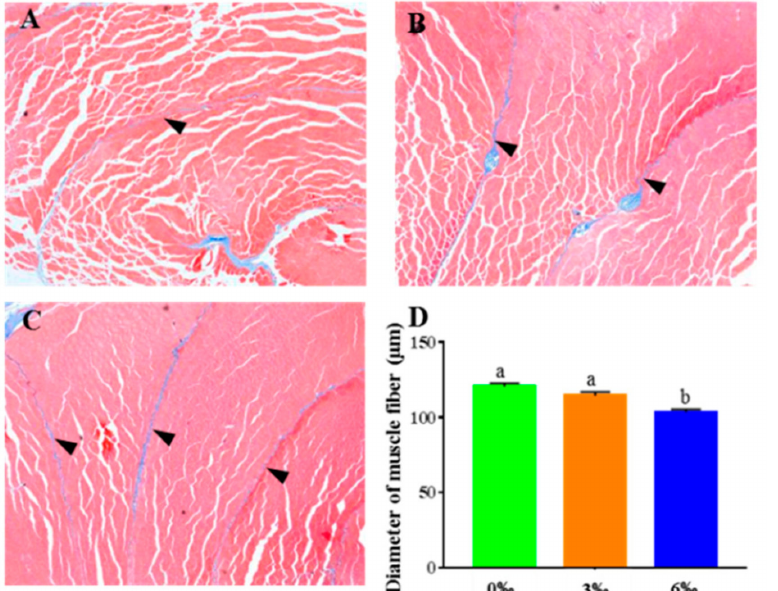
Figure 4. Tissue sections of muscle of grass carp cultured at different salinities (40 × magnification). ( A – C ) correspond to aquaculture salinities of 0‰, 3‰, and 6‰, respectively. Muscle fiber is stained red, and collagen in intramuscular connective tissue is stained blue. The arrows indicate sarcolemma. ( D ) indicates statistics for muscle-fiber diameters. Different lowercase letters indicate significant differences among different salinities ( p <